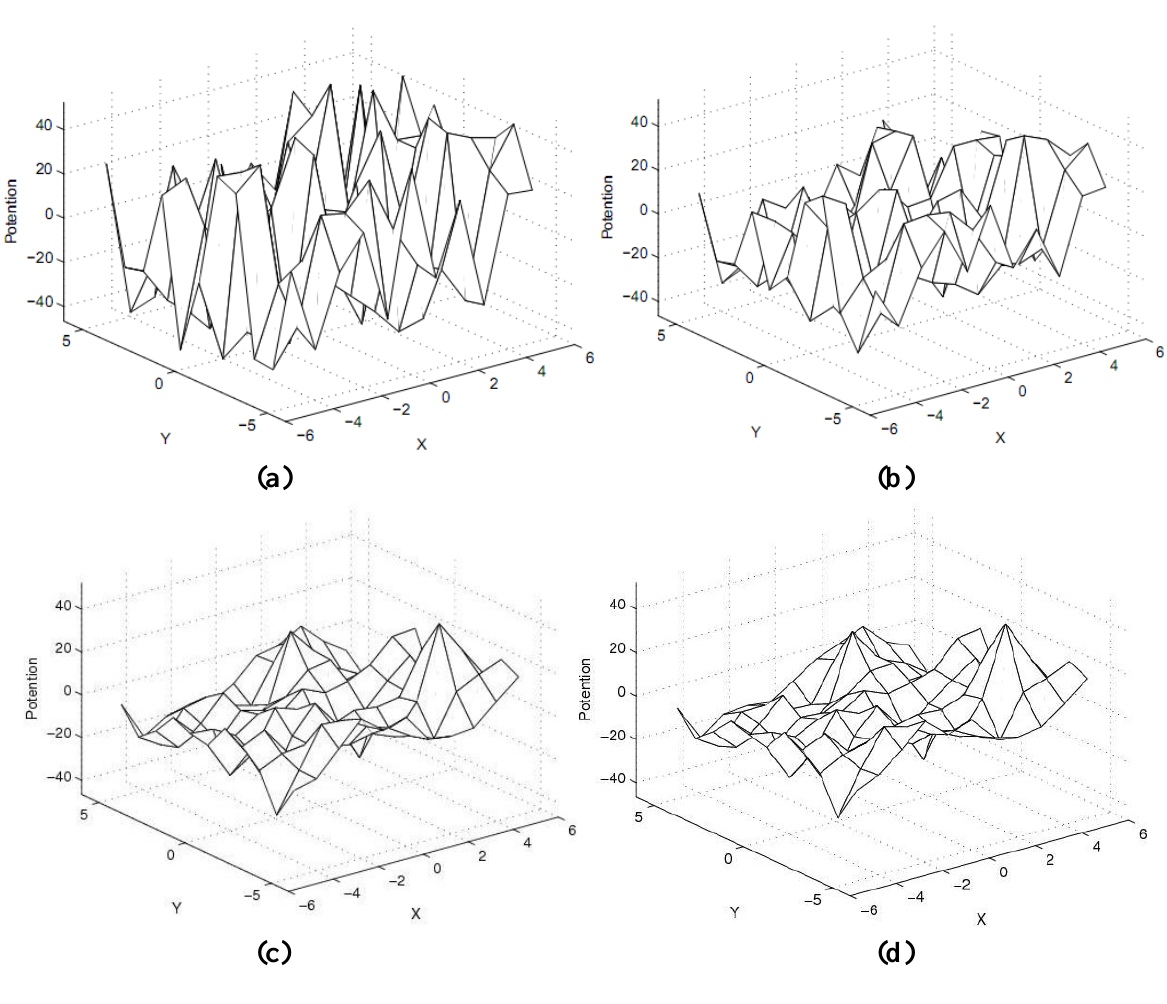
Figure 1. Evolution of information field under the controlling of variable coefficients diffusion equation. (a) Initial potential field; (b) Potential field at T = 1; (c) Potential field at T = 10; (d) Final potential